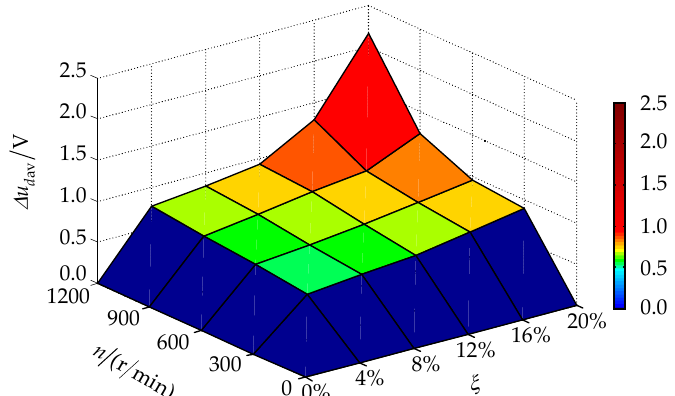
Figure 14. The variation diagram of ∆ u d av with the percentage for the number of short-circuited turns and the speed.